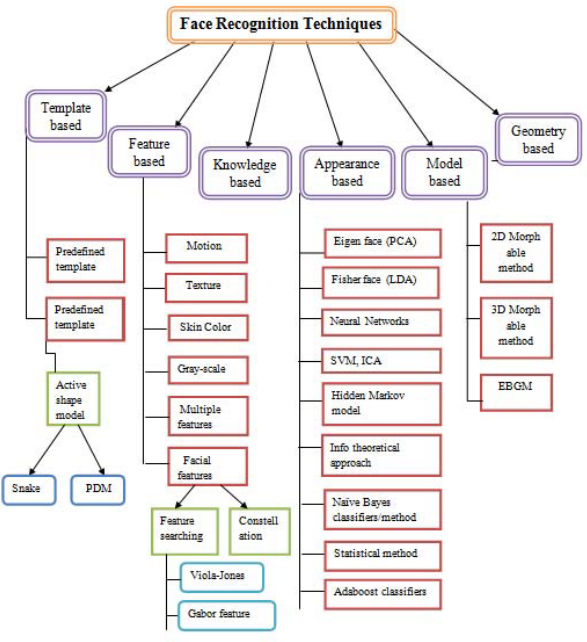
Figure 2 . Identification of One’s Persons